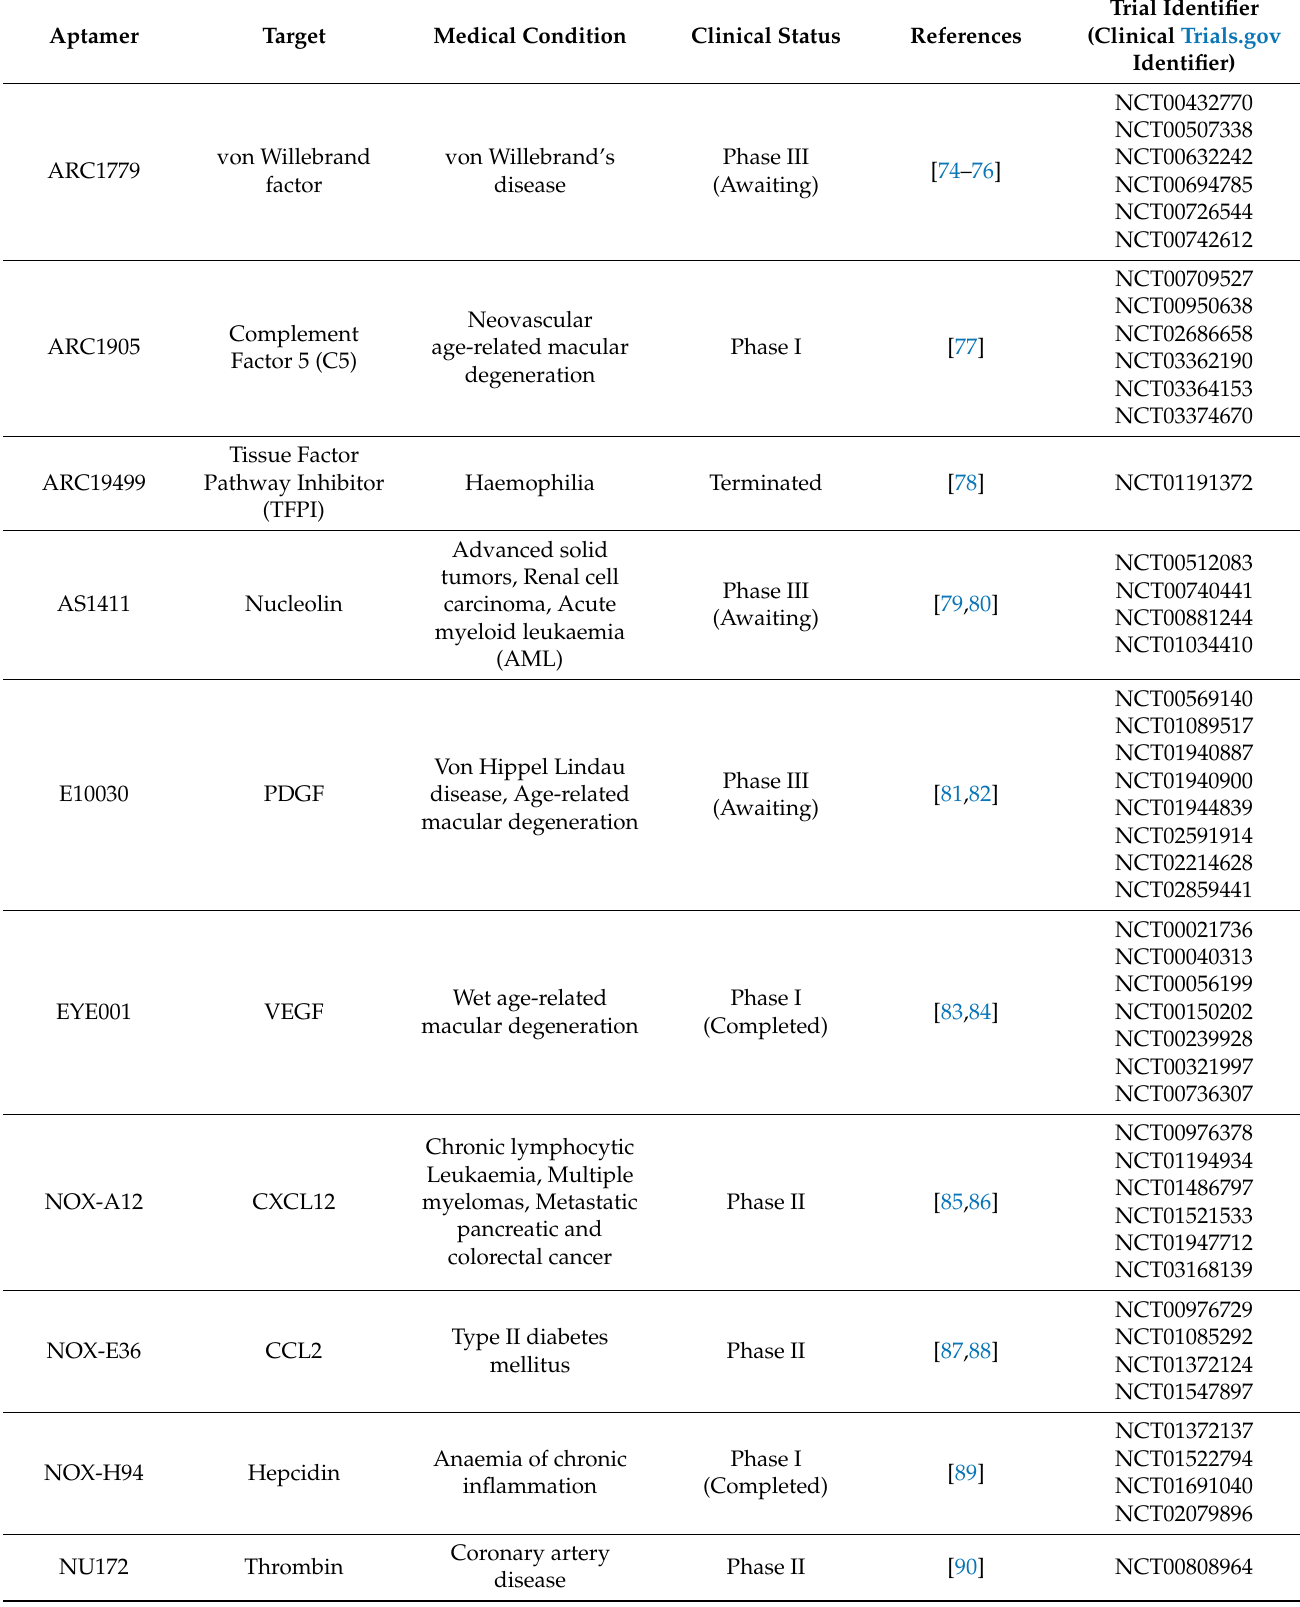
Table 2. Aptamers in Different Phases of Clinical